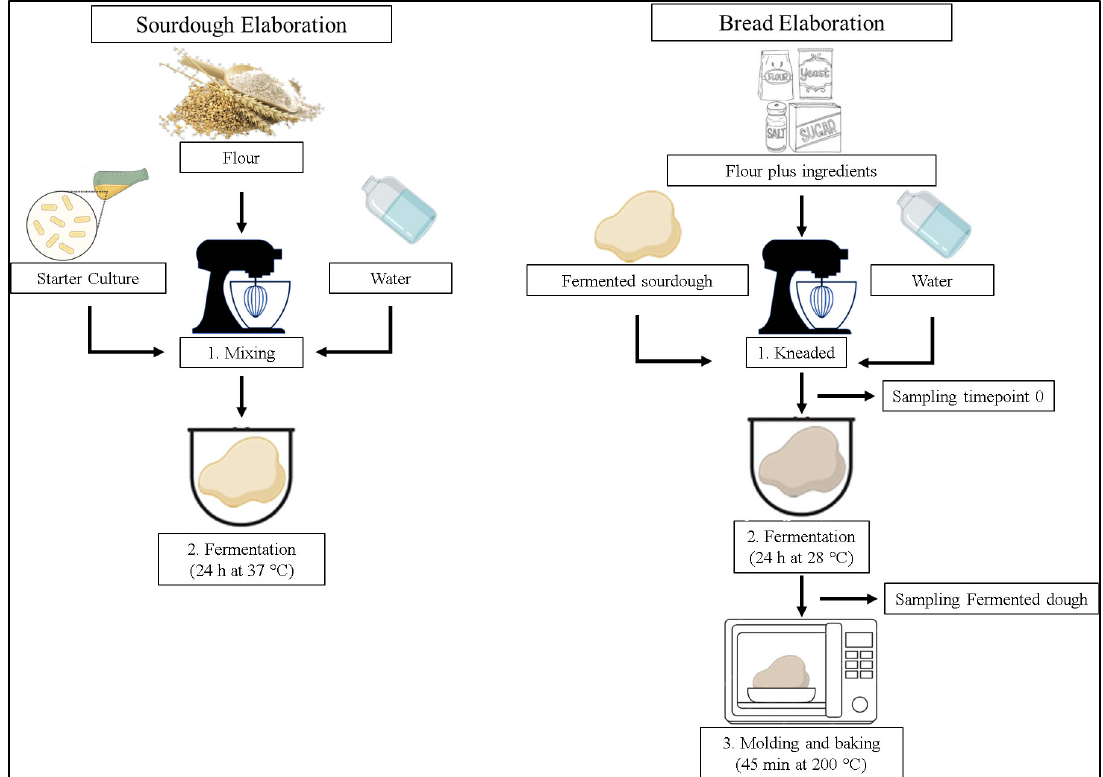
Figure 1. Bread production diagram.